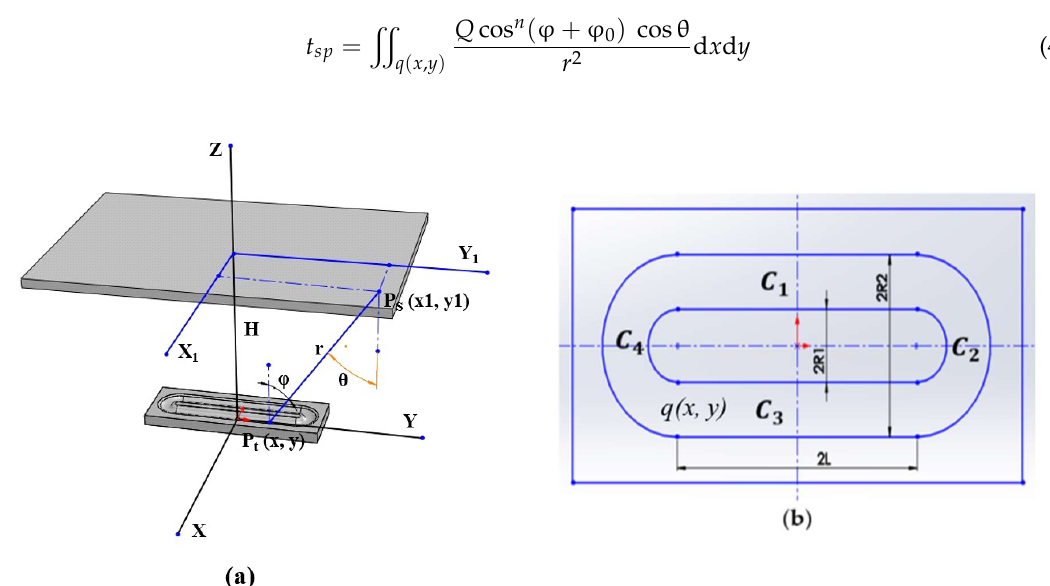
Figure 14. ( a ) Planar substrate holder with rectangular sputtering target, where H is the distance between the target plane and the substrate holder plane, φ is the angle between the normal of the between the target plane and the substrate holder plane, ϕ is the angle between the normal of